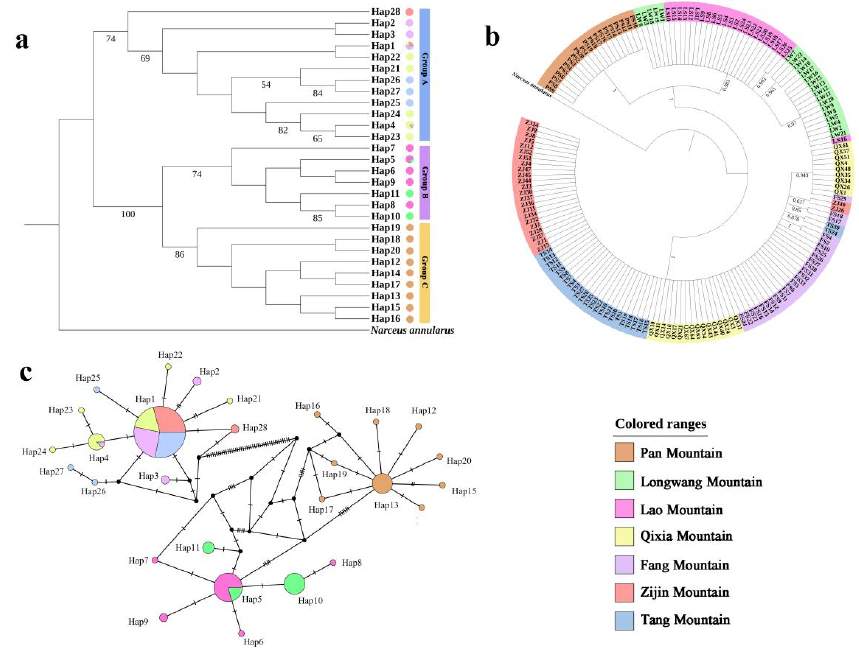
Figure 4. ( a ) Maximum likelihood (ML) tree based on mitochondrial COX2 and Cytb tandem se- quences between seven populations in S. bungii using 28 haplotypes. The numbers on nodes represent the supporting values for ML analysis. Supporting values on nodes below 50 are not displayed. ( b ) Bayesian inference (BI) tree based on mitochondrial COX2 and Cytb tandem sequences between seven populations of S. bungii using 166 individuals. The numbers on nodes represent the supporting values for BI analysis. ( c ) TCS haplotype network based on COX2 and Cytb genes . A dominant role of intrapopulation variations in intragroup variations was found in the analyses of these two geographical regions. This result indicated that two populations within the same geographical region ( S. bungii populations distributed along the Yangtze River in the Nanjing areas) were more distant than those distributed in the Tianjin area.